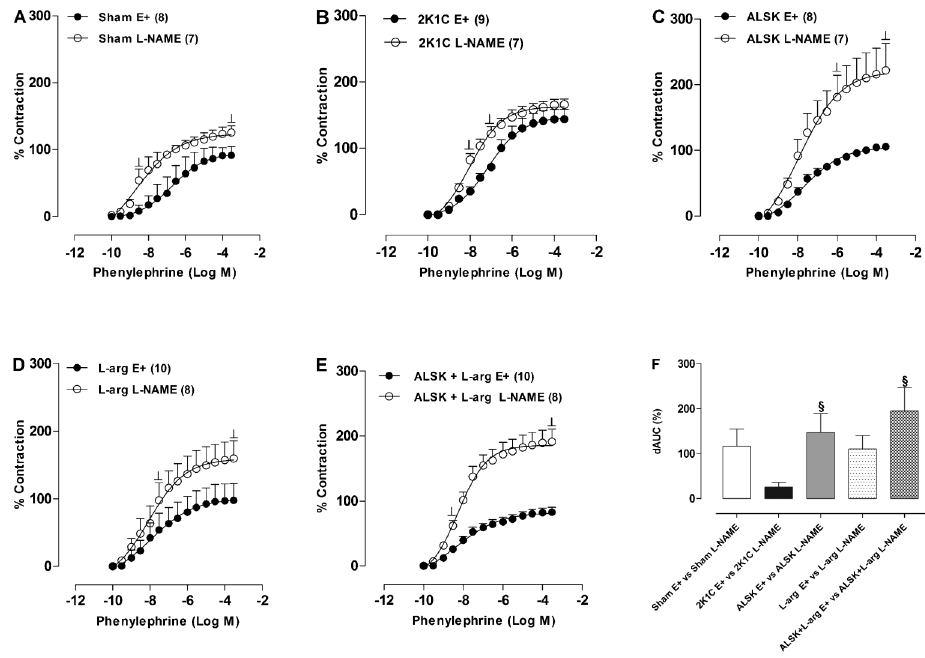
Figure 3. Effects of N G -nitro-L-arginine methyl ester blocker (L-NAME, 100 m M) on the concentration-response curve for phenylephrine in the aortic rings from Sham ( A ), 2K1C ( B ), aliskiren (ALSK) ( C ), L-arginine (L-arg) ( D ) and ALSK++L-arg ( E ) groups in aortic rings in the presence (L-NAME) and absence (E++) of L-NAME blocker. The differences in the area under the concentration-response curves (dAUC) in the presence and absence of L-NAME is shown in F . Data are reported as means±SE. The number of animals in each group is indicated in parentheses. 1 P , 0.05 vs 2K1C and H P , 0.05 vs E++ (two-way ANOVA, followed by Tukey’s post hoc test).